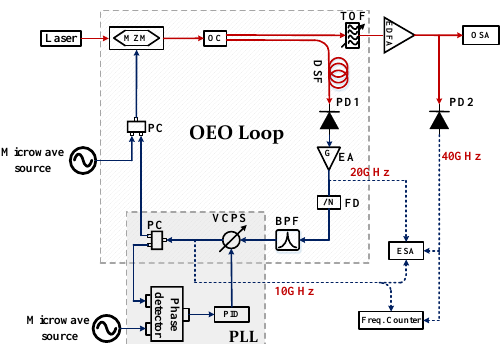
Figure 16. Schematic diagram of the stabilized millimeter-wave OEO scheme in [53]. MZM: Mach-